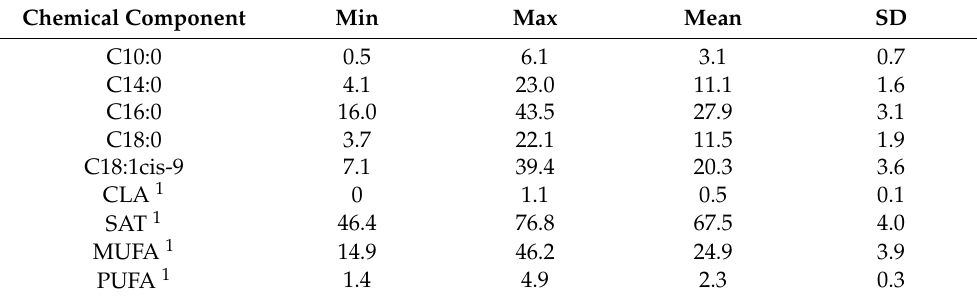
Table 3. Minimum, maximum, mean and standard deviation (SD) of the predicted fatty acid content in 2329 milk samples from 61 cows. All values are expressed as percentage of total weight of fatty